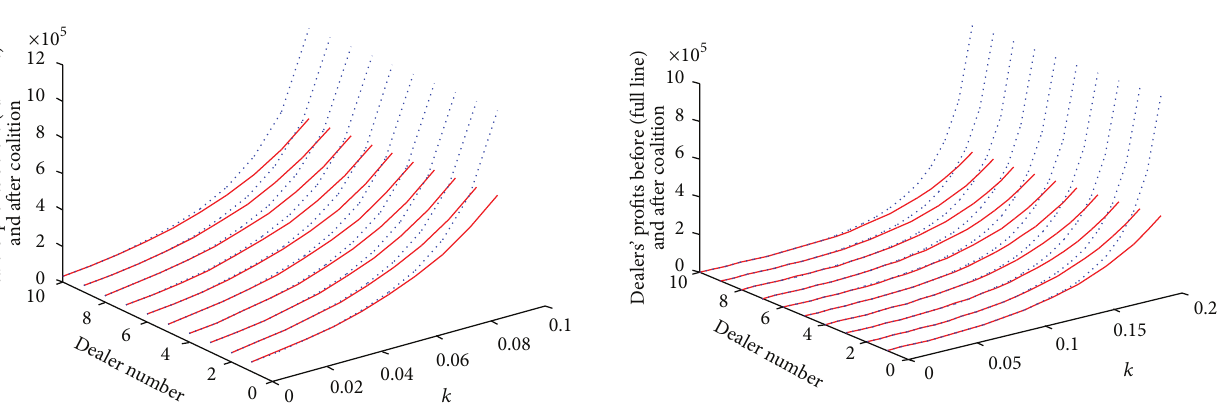
without coalition. The increase of retail price results in the decrease of demand, and the wholesale price is constant with and without coalition, so the supplier’s profit with coalition is less than without coalition. In other words, dealers’ coalition has a negative impact on the supplier.